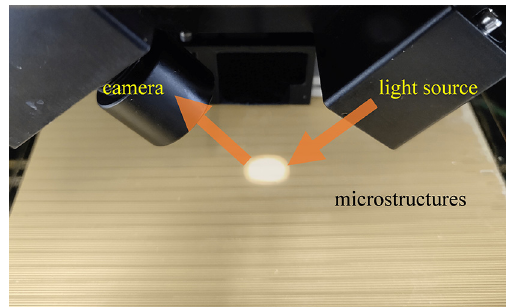
Figure 3. The setup of the optical detection system.